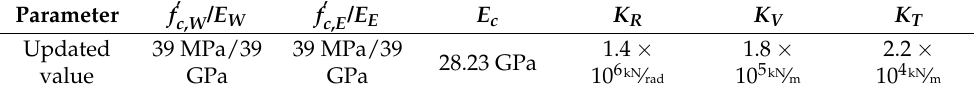
Table 3. The updated FE model parameters after modal-based model